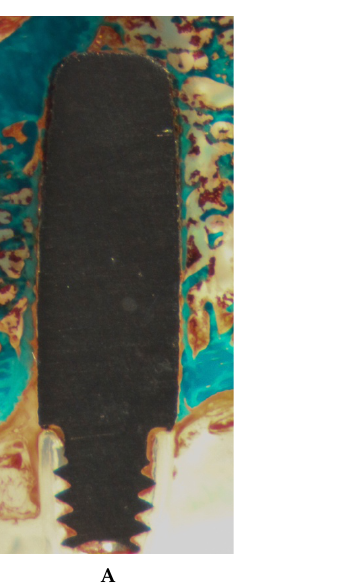
12.8%) after 12 weeks (p = 0.053, Kruskal–Wallis test), see Figure 7.